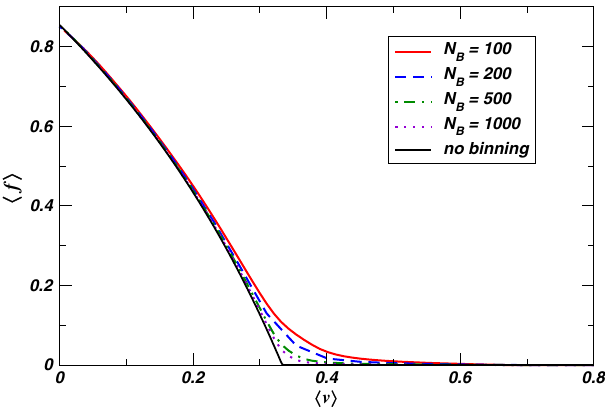
FIG. 11. Effects of the discretization of the BP marginals in the limit q → 0 . The curves represent the average density of nodes that got infected during the epidemic spreading h f i as a function of the average density h v i of immunized nodes for random immunization ( ϵ ¼ 0 ) in the SIR model on random regular graphs of degree K ¼ 4 and uniform transmission probability p ¼ 0 . 5 . For q ¼ 0 , a percolation-like phase transition is expected at h v i ≈ 1 = 3 . For low values of N B , the BP equations (in the single- link approximation, in order to mimic an infinite graph) give a smooth crossover that approaches the correct threshold effect by increasing the number of